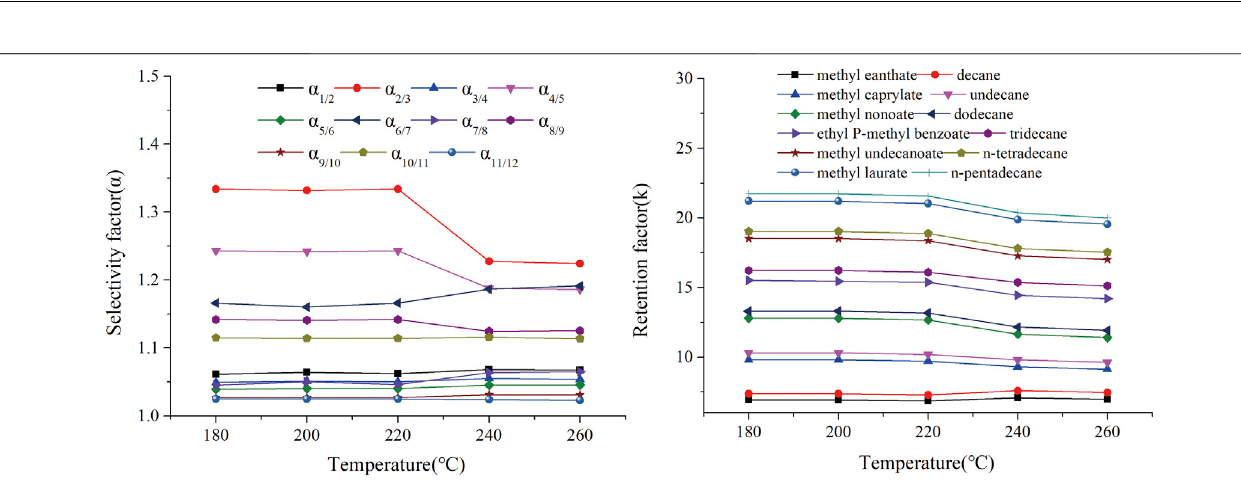
Frontiers in Chemistry |